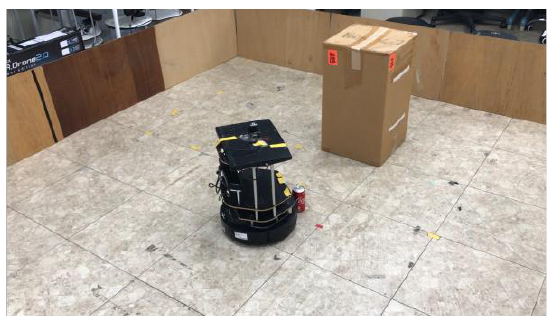
Figure 20. Third-person view of mobile robot reaching the target object in the first arena.